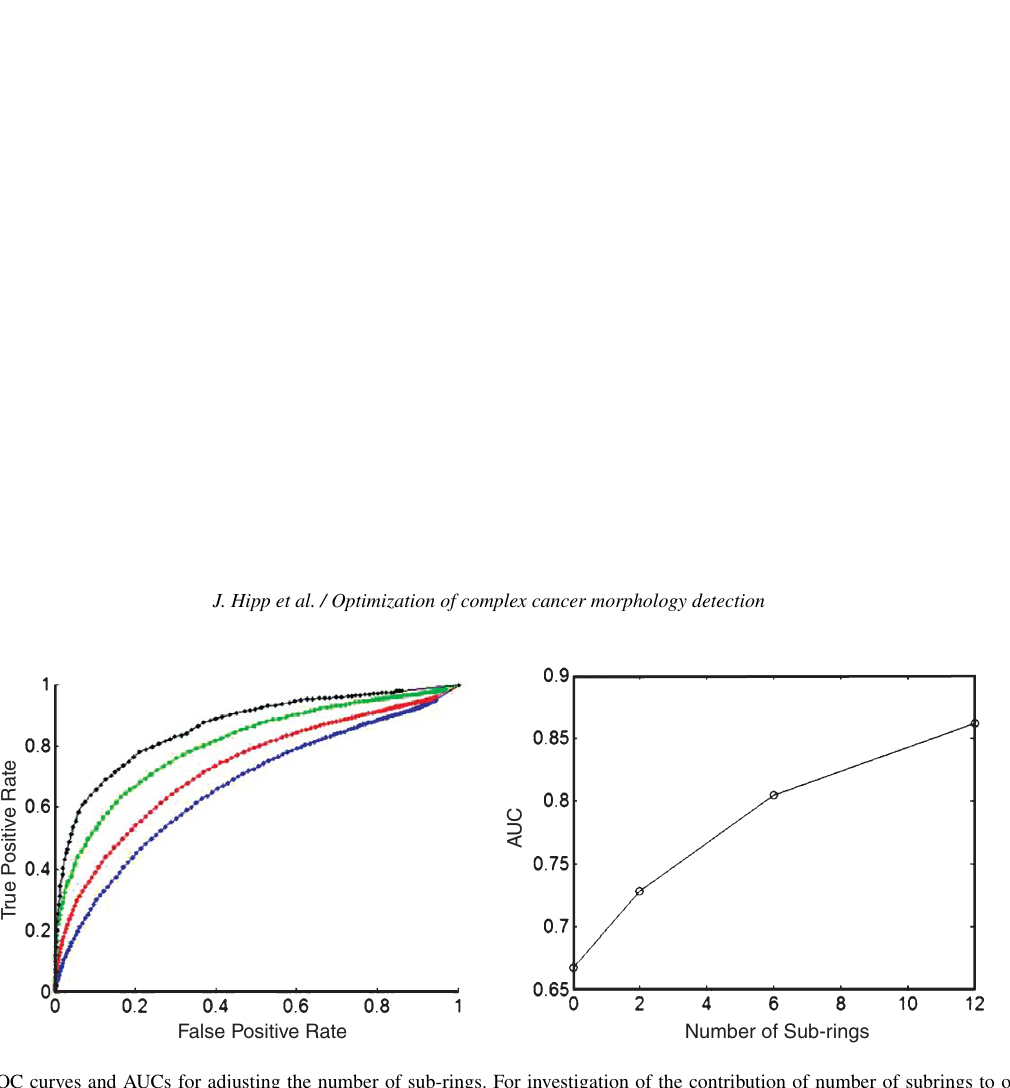
Fig. 3. ROC curves and AUCs for adjusting the number of sub-rings. For investigation of the contribution of number of subrings to overall performance, a ring vector of 13 pixels in diameter was selected. SIVQ analysis was performed by altering the number of sub-rings: 0 (blue), 2 (red), 6 (green), and 12 (black), skipping every other ring. The panel to the left shows incremental improvement in the ROCs as the number of sub-rings is increased. The right panel demonstrates incremental improvements in the AUCs as the number of sub-rings are increased. The maximal AUC was identified with the maximal number of 12 sub-rings and was associated with an AUC of